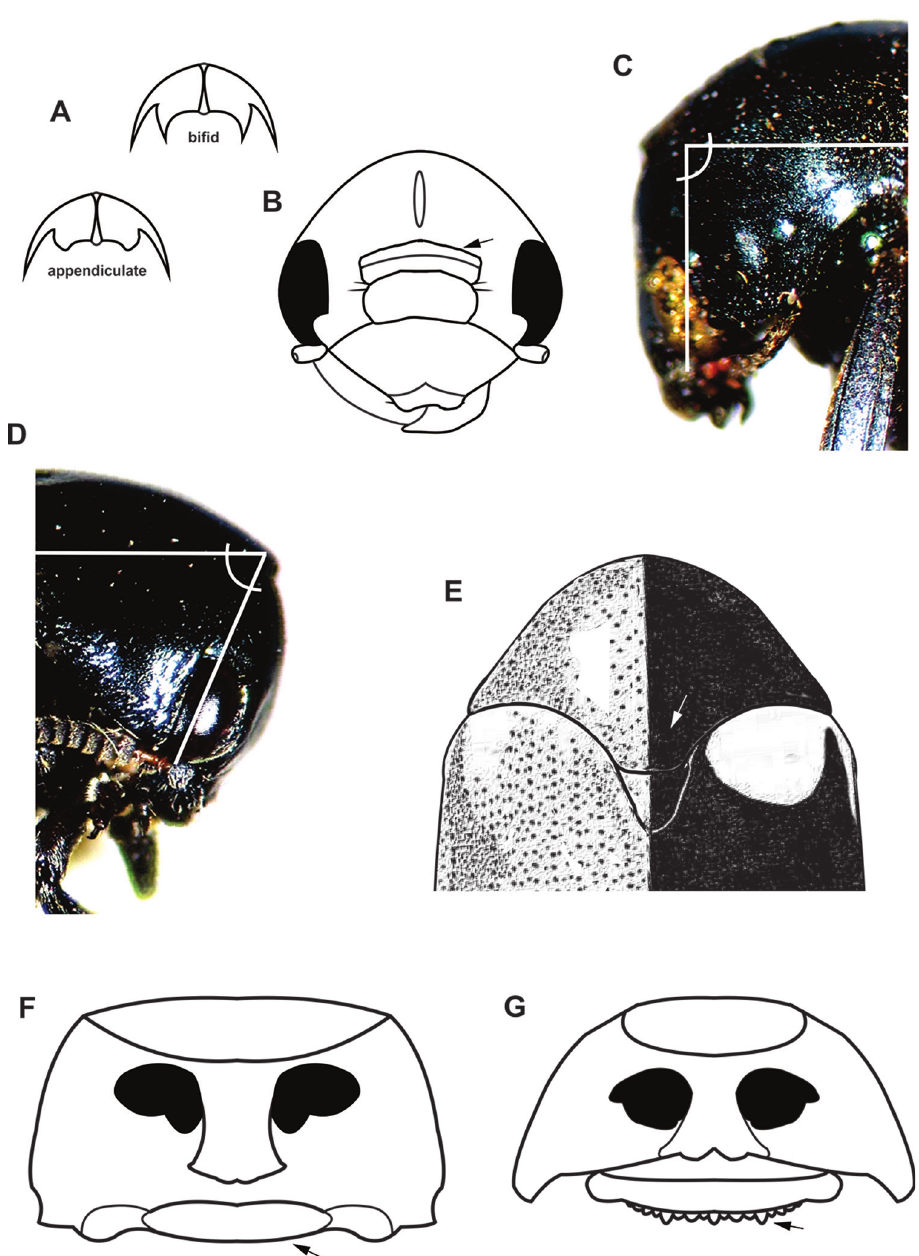
Figure 3. Diagnostic characters plate 2. A Tarsal claws bifid or appendiculate B Frons with deep trans- verse sulcus. C Head forming straight angle with respect to pronotum D Head strongly directed down- ward, forming 45º angle with respect to pronotum E Posterior margin of pronotum broadly expanded, forming distinct scutellar lobe with angular corners (drawn after Monrós 1953a) F Pronotum margined at base, not crenulate G Pronotum not margined at base,